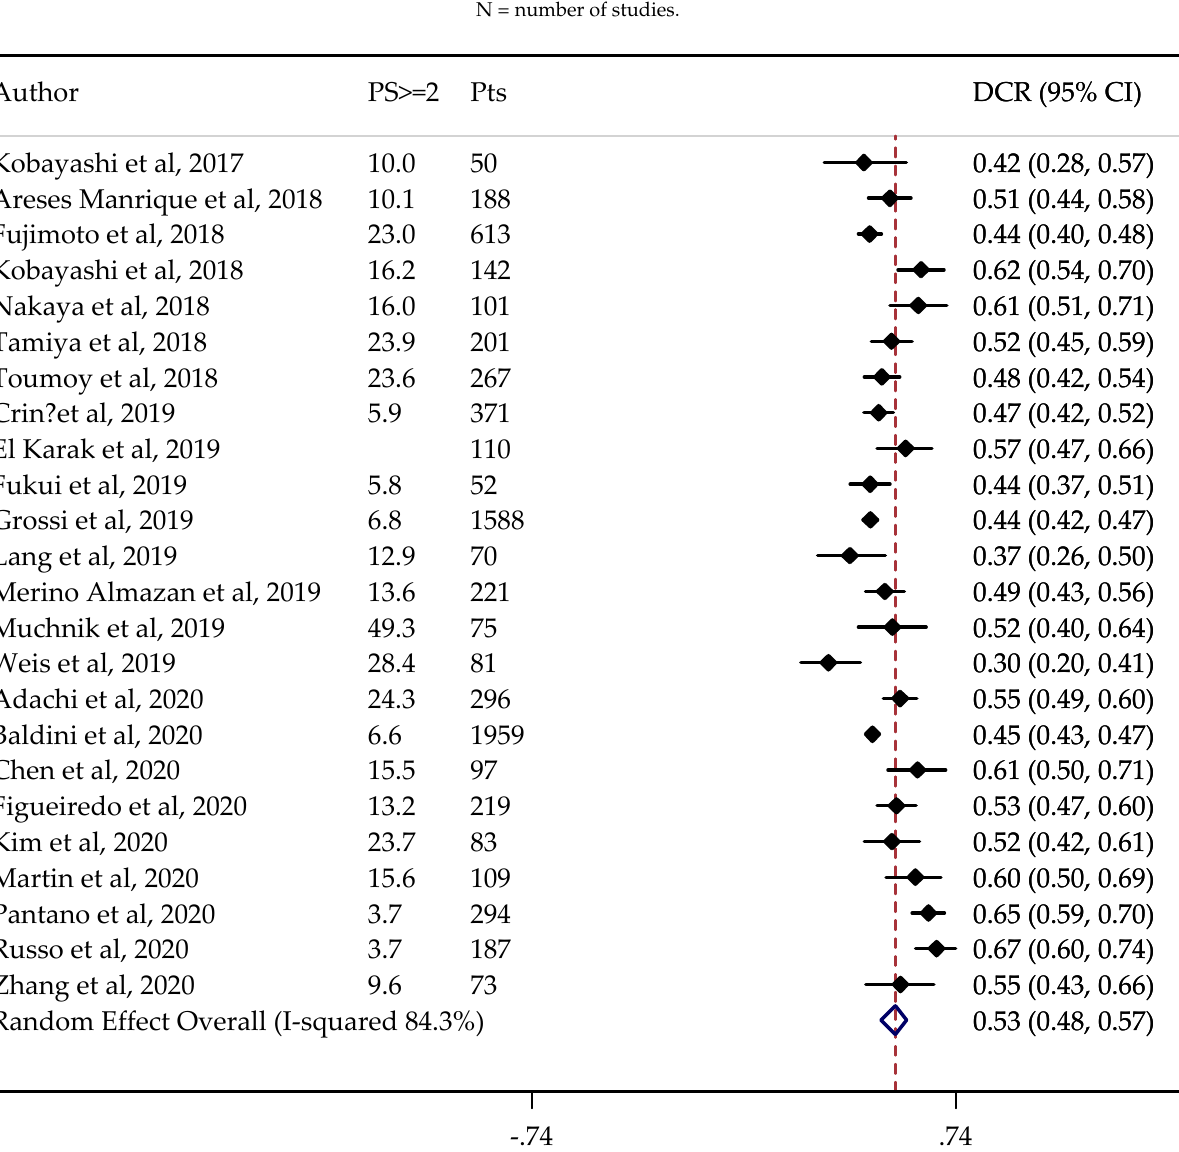
Figure 3. Forest plot of NSCLC disease control rate (DCR) adjusted for performance status (PS). The DCRs were either taken directly from individual studies or calculated using reported numbers of responding, stable, and total treated patients. PS ≥ 2: proportion of patients with PS ≥ 2.